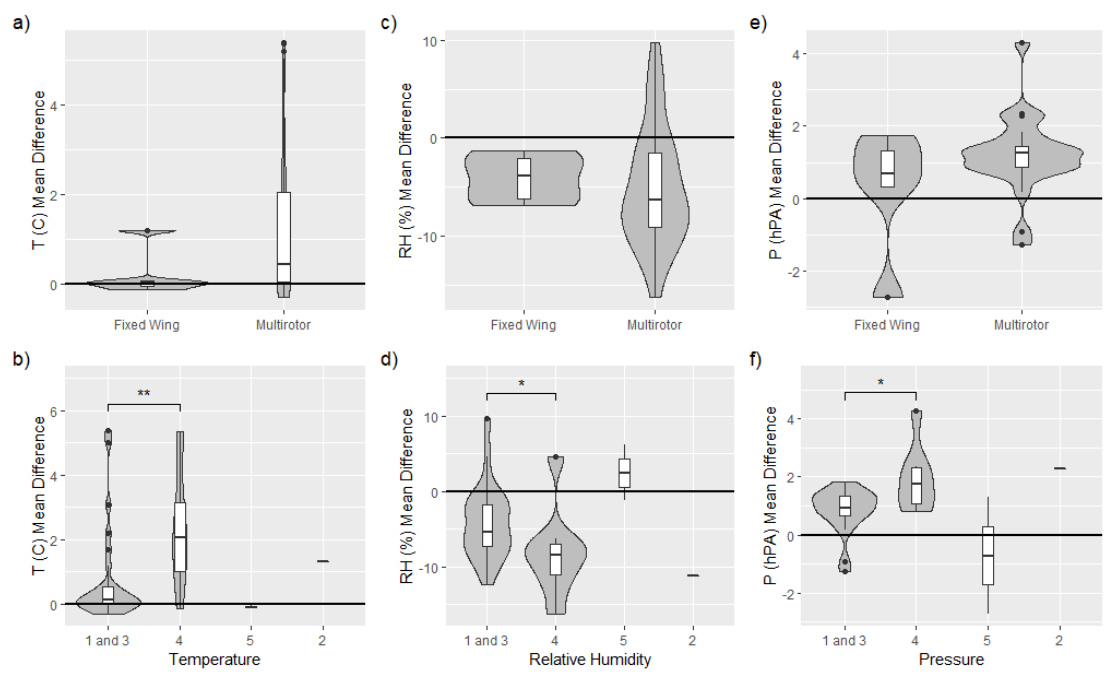
Figure 10. Comparison of temperature, relative humidity, and pressure measurement differences in relation to the MURC measurements, represented with the black line at 0. Averages of parameter measurement differences over each platform’s MURC intercomparison loiter period are compared between platform groups ( a , c , e ) and sensor configuration groups ( b , d , f ). For sensor configurations, 1 and 3 are sensors not impacted by solar radiation shielding or aspiration (1) or sensors with both solar radiation shielding and aspiration (3), 4 are sensors with solar radiation shielding only, 5 are sensors with aspiration only, and 2 are sensors with neither solar radiation shielding or aspiration. Wilcoxon rank-sum tests were performed ( p ( T ) = 0.009; p ( RH ) = 0.039; p ( P ) =